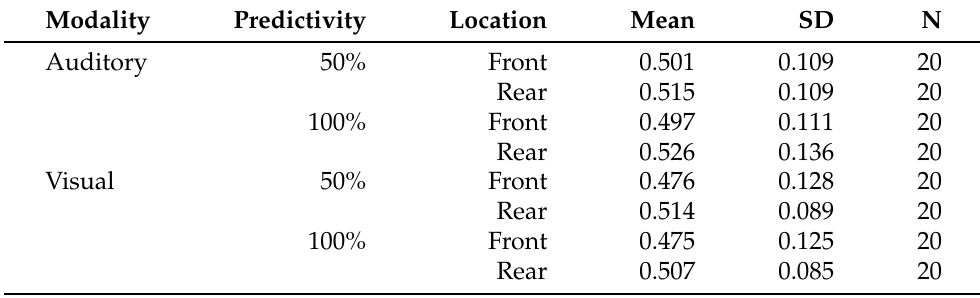
Table 1. Mean RT (in seconds) as a function of experimental factors for Gaze-Initiation.